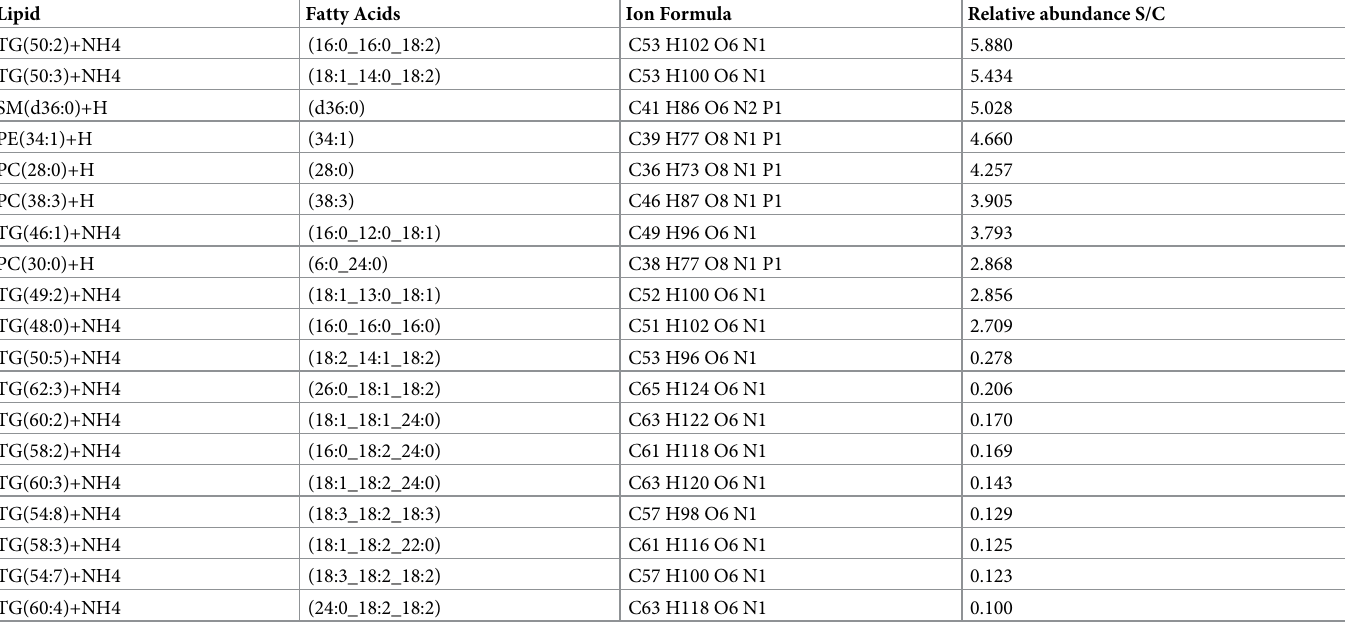
Table 5. Top 10 lipids upregulated and downregulated in dogs with sepsis C30 positive ion mode. Lipid Fatty Acids Ion